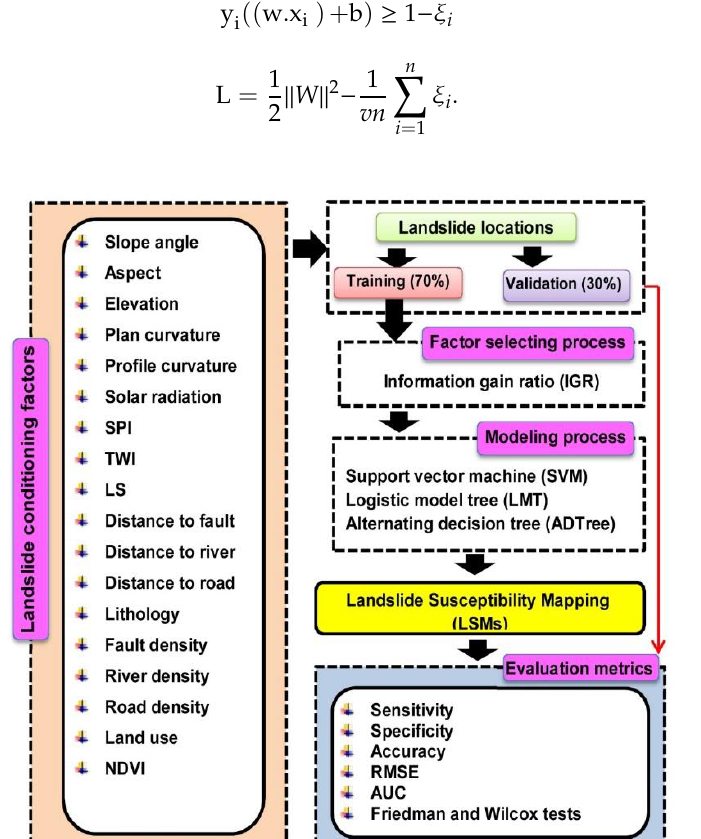
Figure 4. Flowchart of the methodology used in this study.